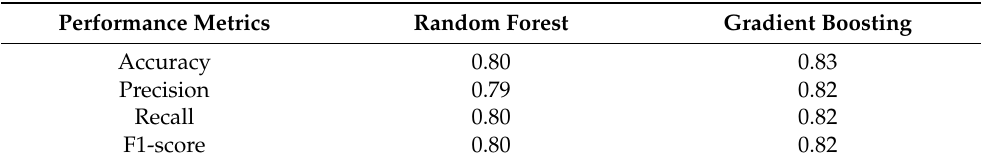
Table 3 showed a summary of the performance of the classification models. Table 3. Results of classification models for normal vs. glioma tissue biopsies using Raman Spec-